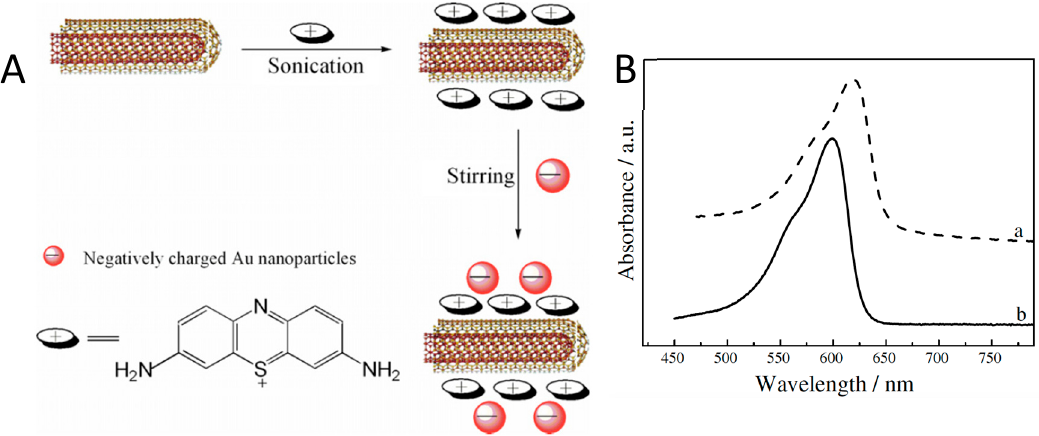
Figure 7. ( A ) Proposed mechanism of thionine-mediated adsorption of gold nanoparticles on MWCNTs; ( B ) UV–Vis absorption spectra of: (a) MWCNT/thionine solution and(b) aqueous thionine solution.